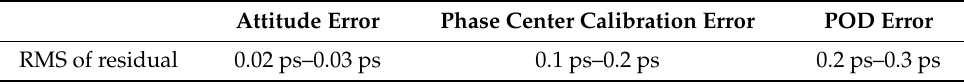
Table 4. The effect of comprehensive error factors on the correction of total relativistic effects (including attitude error, phase center calibration error and POD